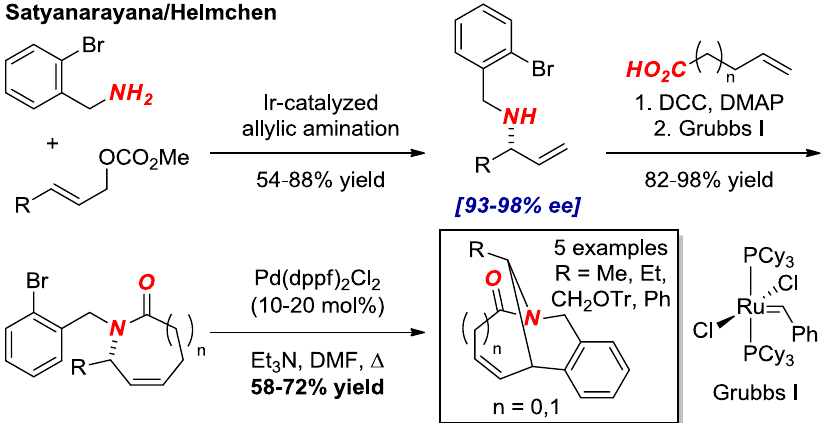
Figure 14. Enantioselective Synthesis of Bridged Lactams by Allylic Amination.